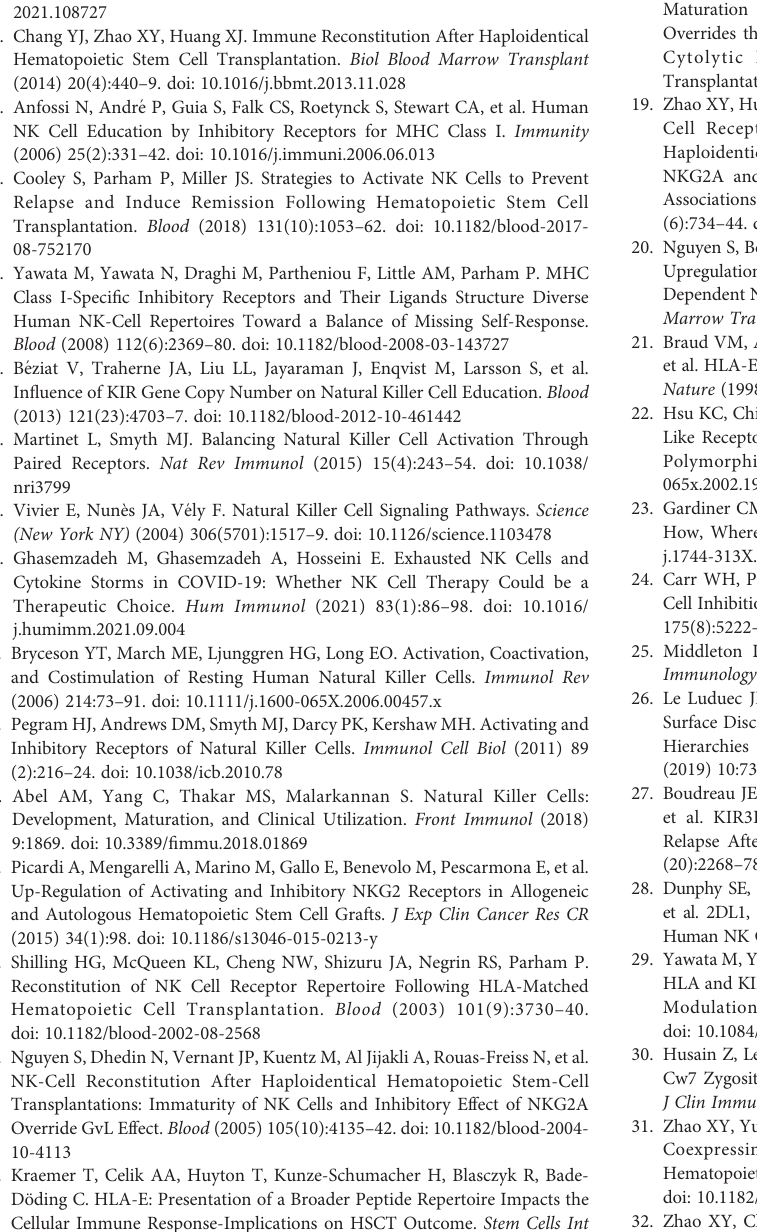
Each circle shows one patient (Spearman rank correlation test). The blue line is the correlation line. Supplementary Figure 8 | An increased proportion of KIR2DL2/L3 single- positive/NKG2C+ NK cells correlated with higher incidence of GVHD. In Kaplan- Meier method, 100 days cumulative incidence of aGVHD in the cohort (KIR2DL2/L3 single positive/NKG2C+ NK cells > 20.09%, n = 69, red line; KIR2DL2/L3 single positive/NKG2C+ NK cells < 20.09%, n = 27, blue line) after